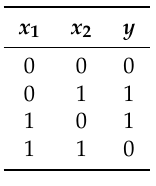
Table 4. Truth table for